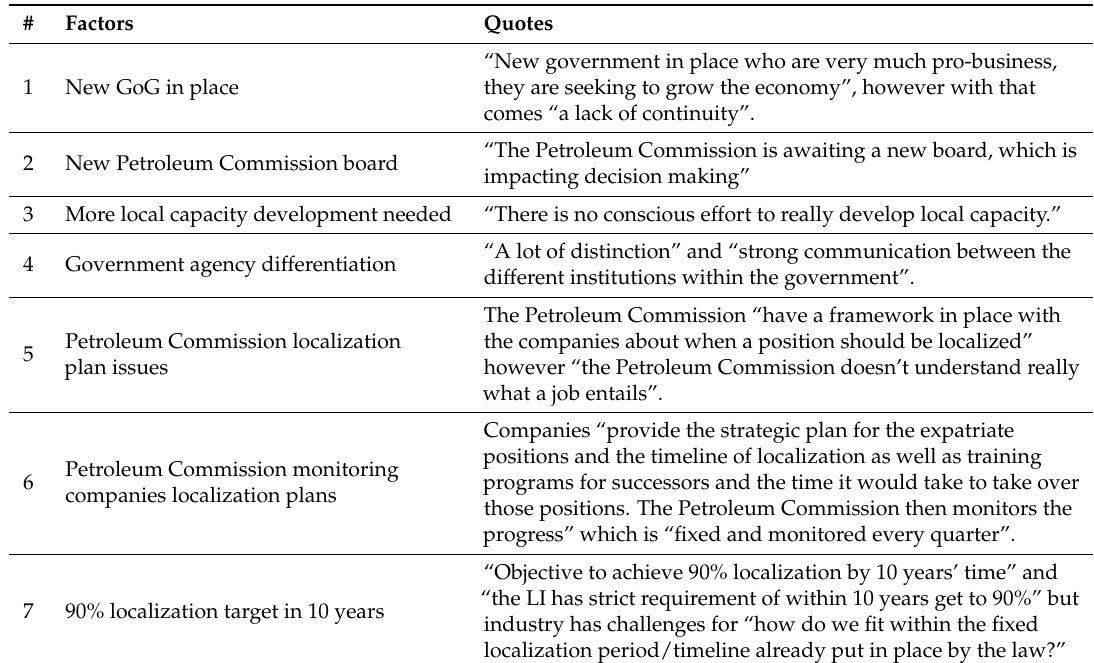
Table 3. ‘Government & legislation’